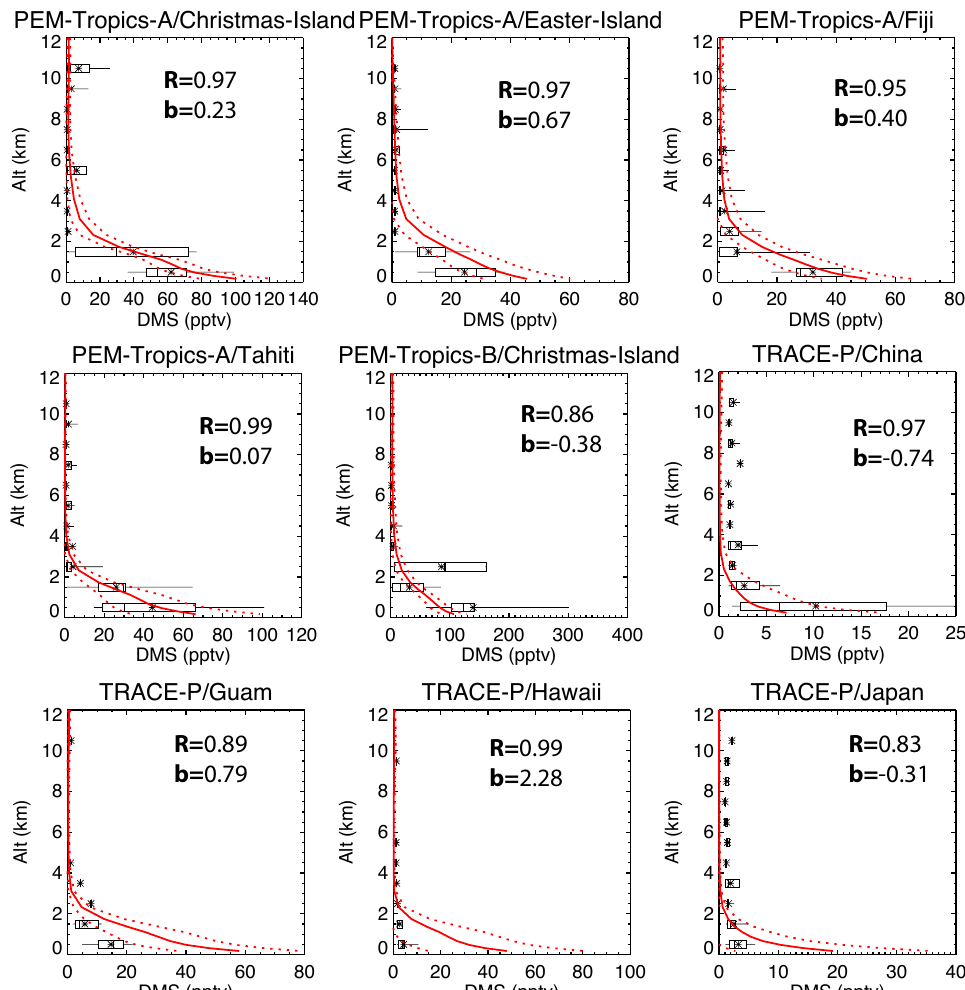
Fig. 7. DMS vertical profiles over the Pacific Ocean. Observations are from PEM-Tropics A (September–October 1996), PEM-Tropics B over the observational domain (solid line: mean; dash lines: ± one standard deviation). For the observed values (in black), the whiskers show 5th and 95th percentiles, the boxes show 25th and 75th percentiles, and the star symbols and thicker vertical lines inside the boxes show mean and median. Normalized model mean bias (“b”) and the correlation coefficient between the model and observations (“R”) are shown in each panel. Values of b and R are calculated using observed values provided at discrete altitudes and model values interpolated from model grid to those